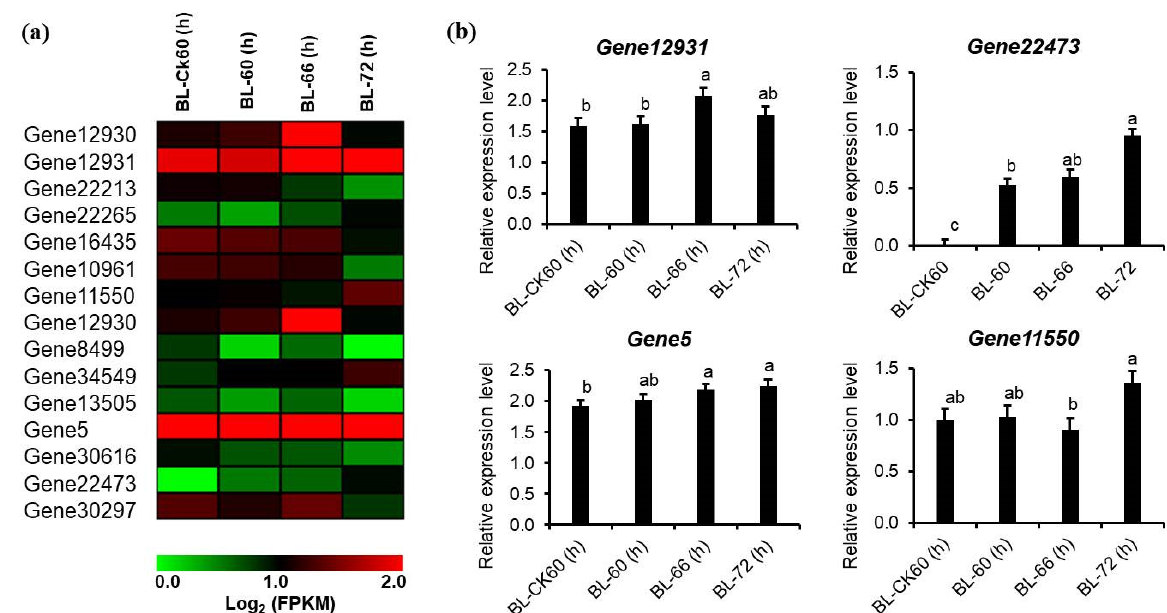
Figure 8. Expression profiling of phenylpropanoid biosynthesis DEGs in the hypocotyl of R. pseudoacacia -148 during adventitious root formation; ( a ) Heat map illustration of log2 (FPKM) values for annotated genes during phenylpropanoid biosynthesis pathway; ( b ) Relative expression of phenylpropanoid biosynthesis pathway genes as determined by RT-qPCR. The data presented are the average of three technical replicates. Different letters indicate significant difference by least significant difference (LSD) test ( p ≤ 0.05). Bar = SD.